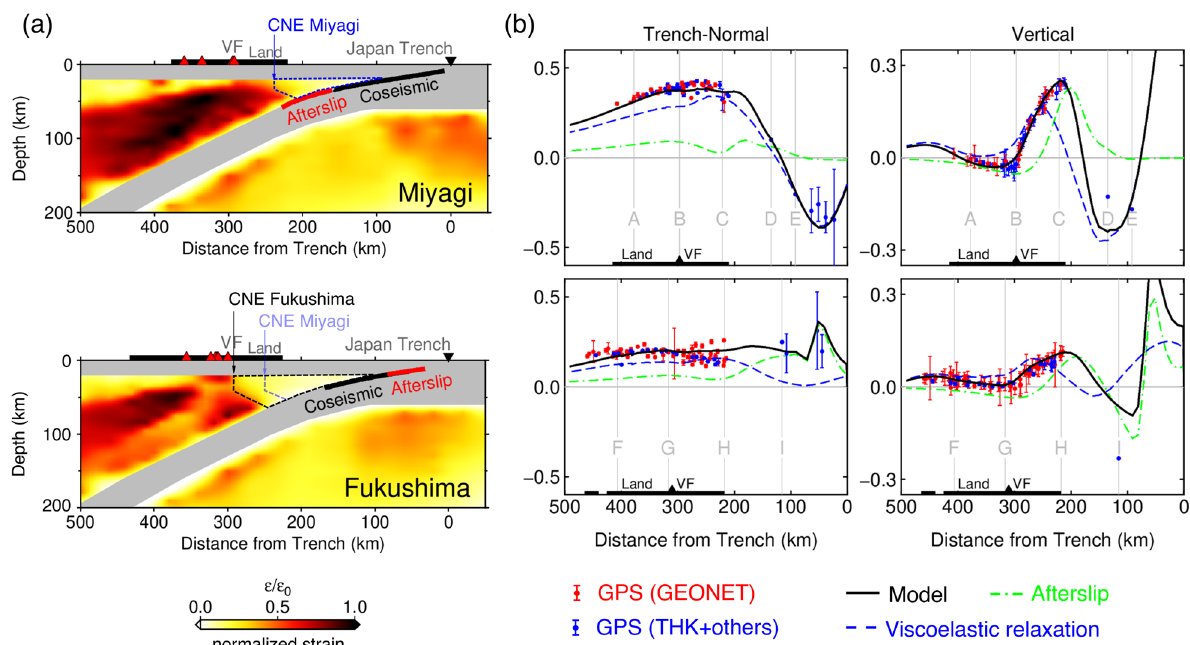
Fig. 15 a Total strain by viscous flow during ~ 5 years of postseismic deformation along the Miyagi-Yamagata region and the Fukushima-Niigata region (after Dhar et al. 2022). b The two-dimensional projection of modeled displacements from September 2012 to May 2016 along the Miyagi-Yamagata region and Fukushima-Niigata